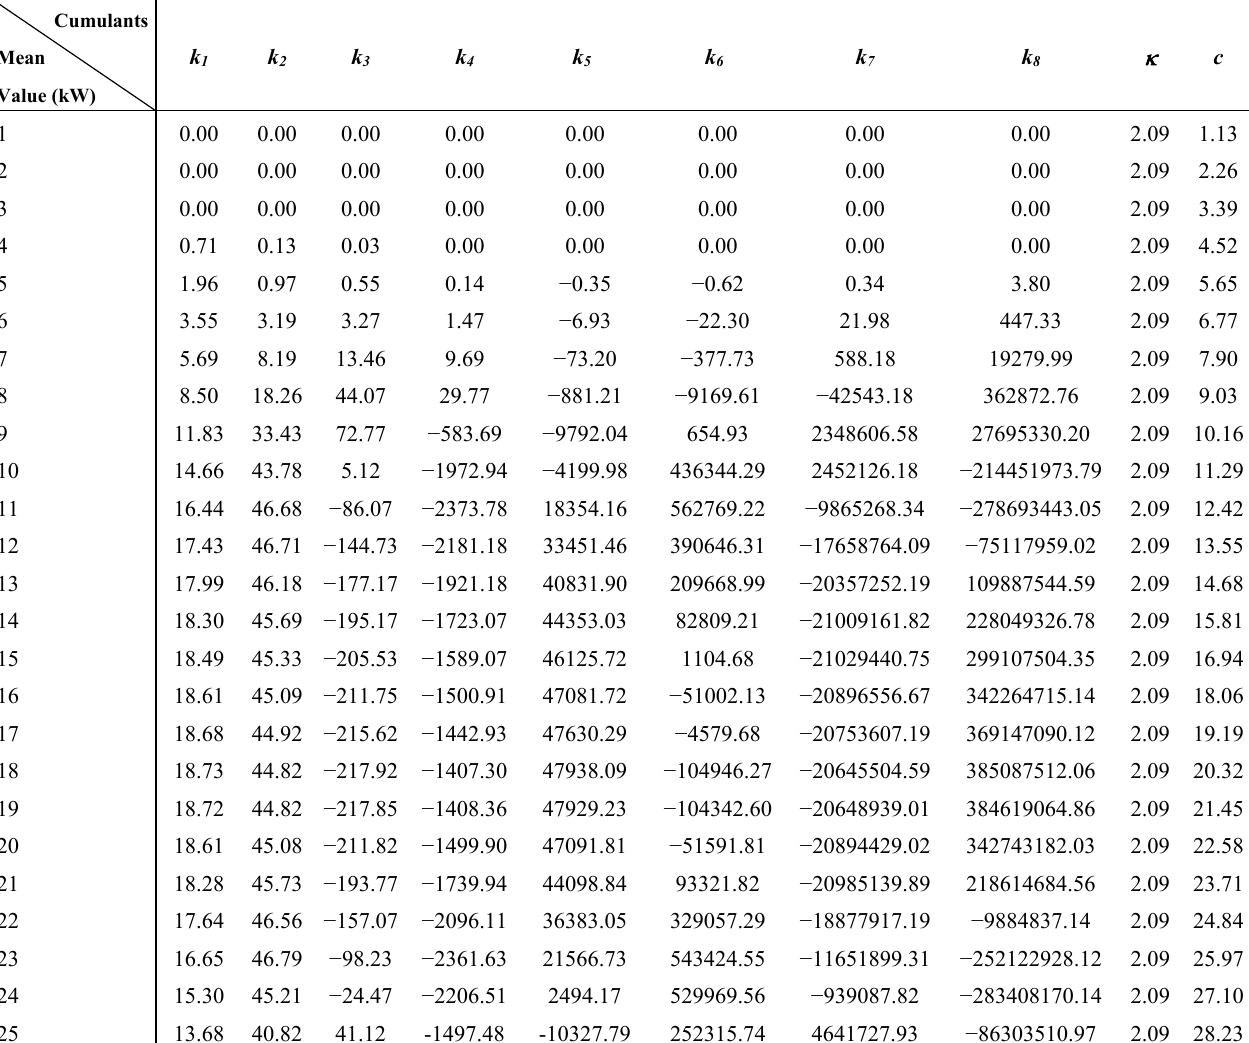
Table 3. Cumulants of wind power levels with different values of κ and c